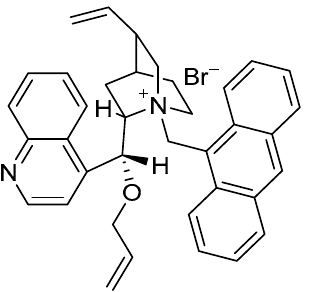
Figure 3. Structure of O -(9)-allyl- N -(9-anthracenylmethyl)-cinchonidinium bromide.